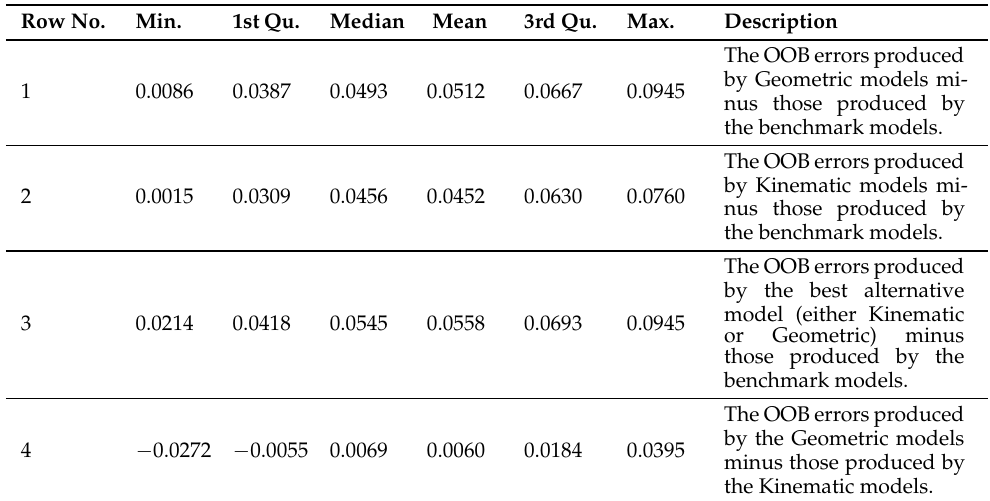
Table 4. The descriptive statistics of the geometric descriptor-based, kinematic descriptor-based, and benchmark models, according to the classification